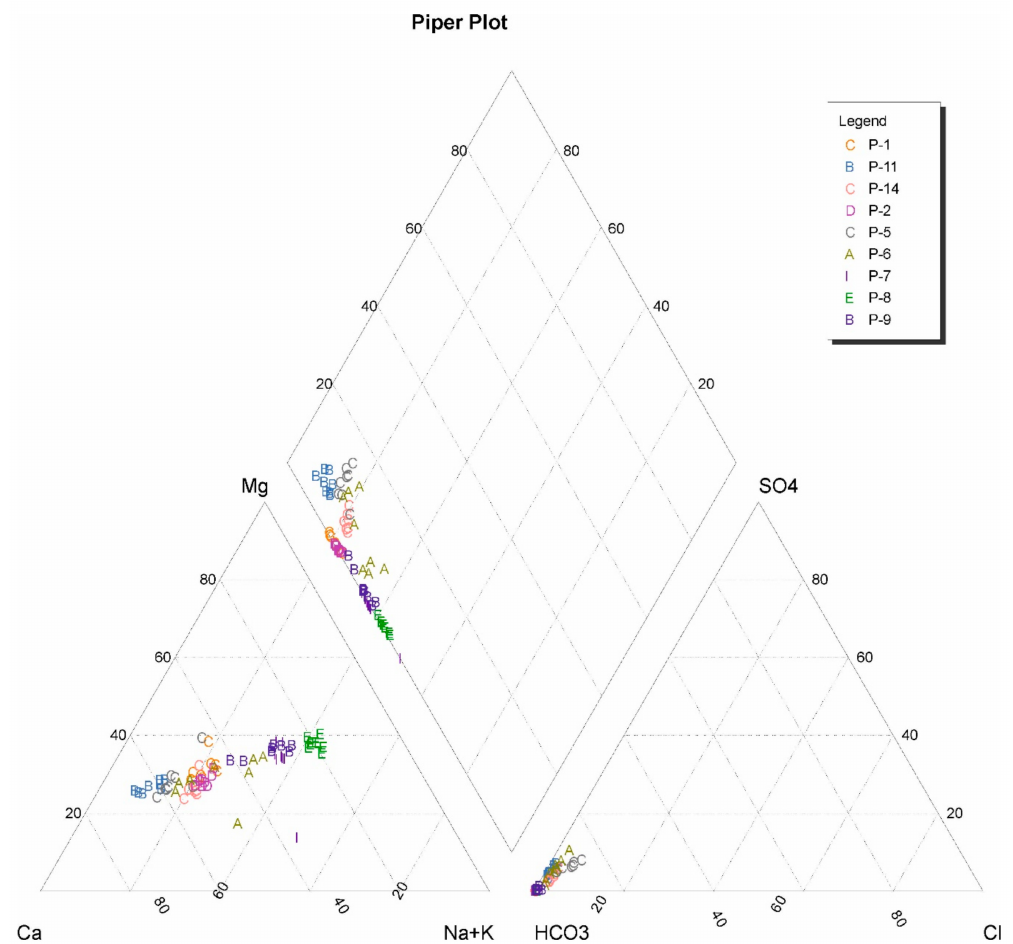
Figure 5. Piper diagram of analyzed boreholes.